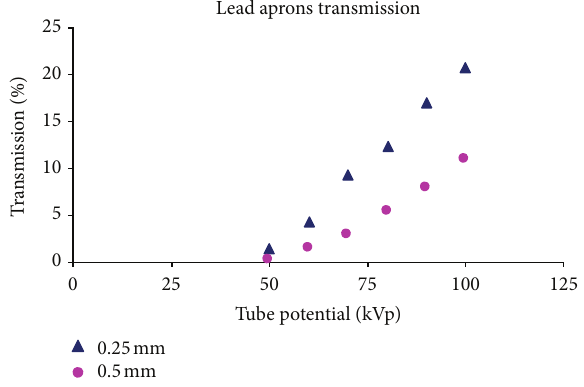
Figure 1: The transmission ratio versus the tube potential (kVp).